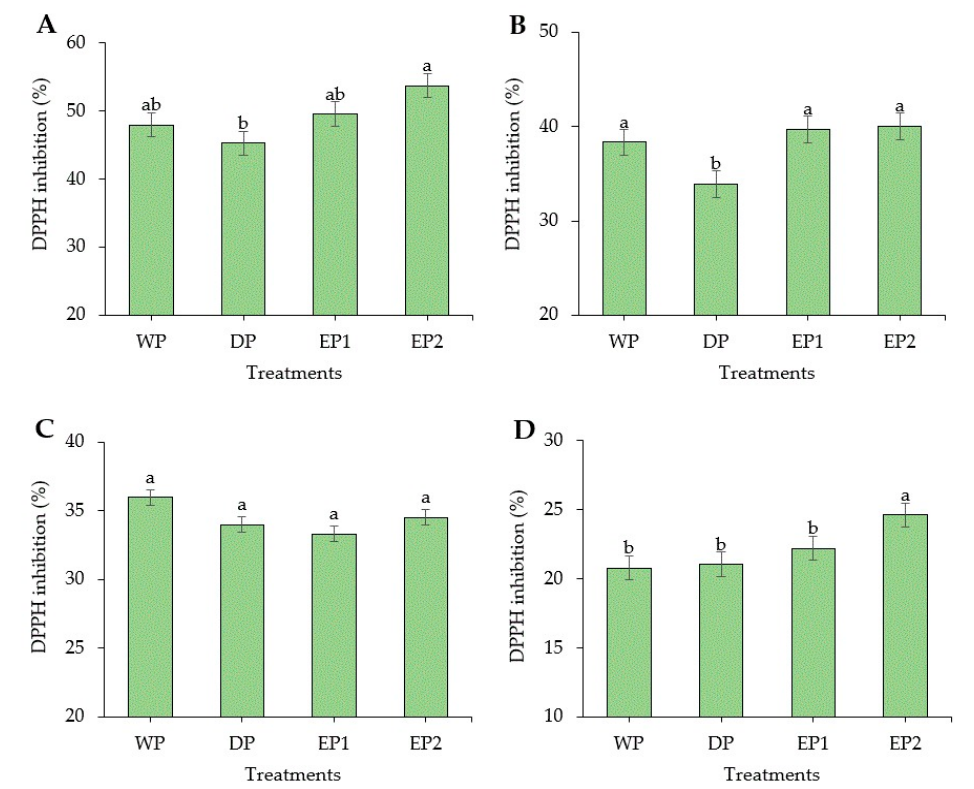
Figure 2. 2,2-diphenyl-1-picrylhydrazyl (DPPH) inhibition (%) of green and roasted coffee beans obtained using different processing methods. ( A : Green beans; B : Light roasted, C : Medium roasted; D : Dark roasted). EP1: elephant dung coffee (pulp was completely digested); EP2: elephant dung coffee (pulp was not digested); WP: wet-processed beans; DP: dry-processed beans. Different letters above the bars indicate statistically significant difference at p < 0.05.